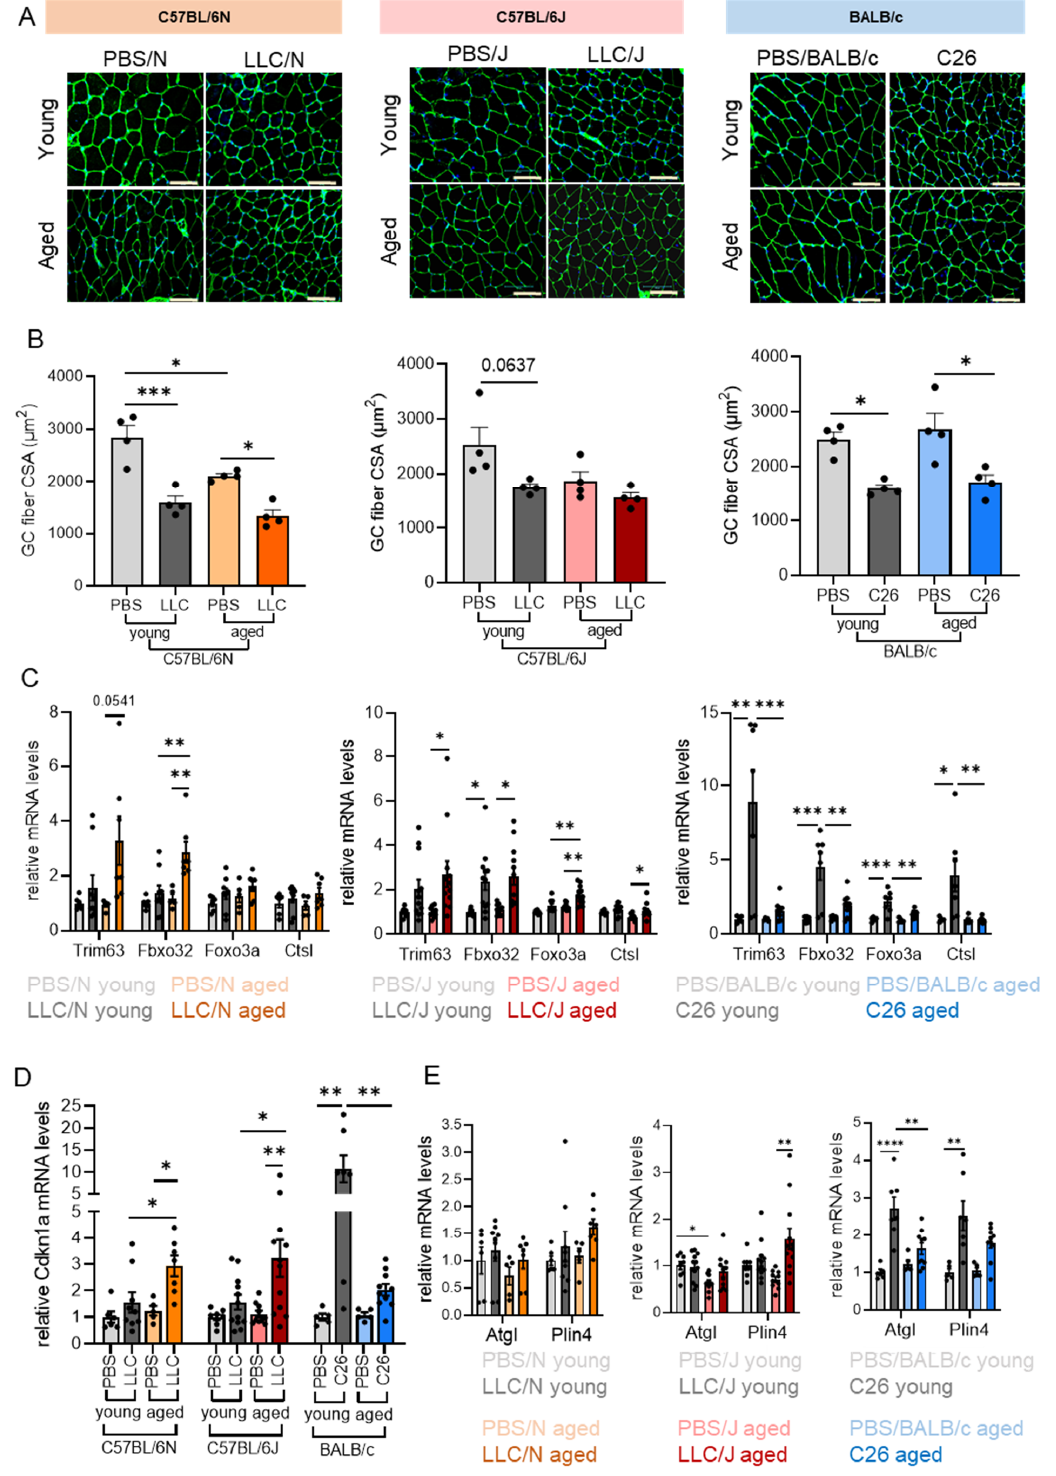
Figure 4. Aging increases the tumor-induced expression of atrogenes in cachectic muscle. ( A ) Representative staining for wheat germ agglutinin (green) and nuclei (blue) showing morphological changes in gastrocnemius muscles of PBS, LLC, and C26-injected young and aged mice; 20x magnification, scale bar 100 µ m. ( B ) Quantification of fiber cross-sectional area in